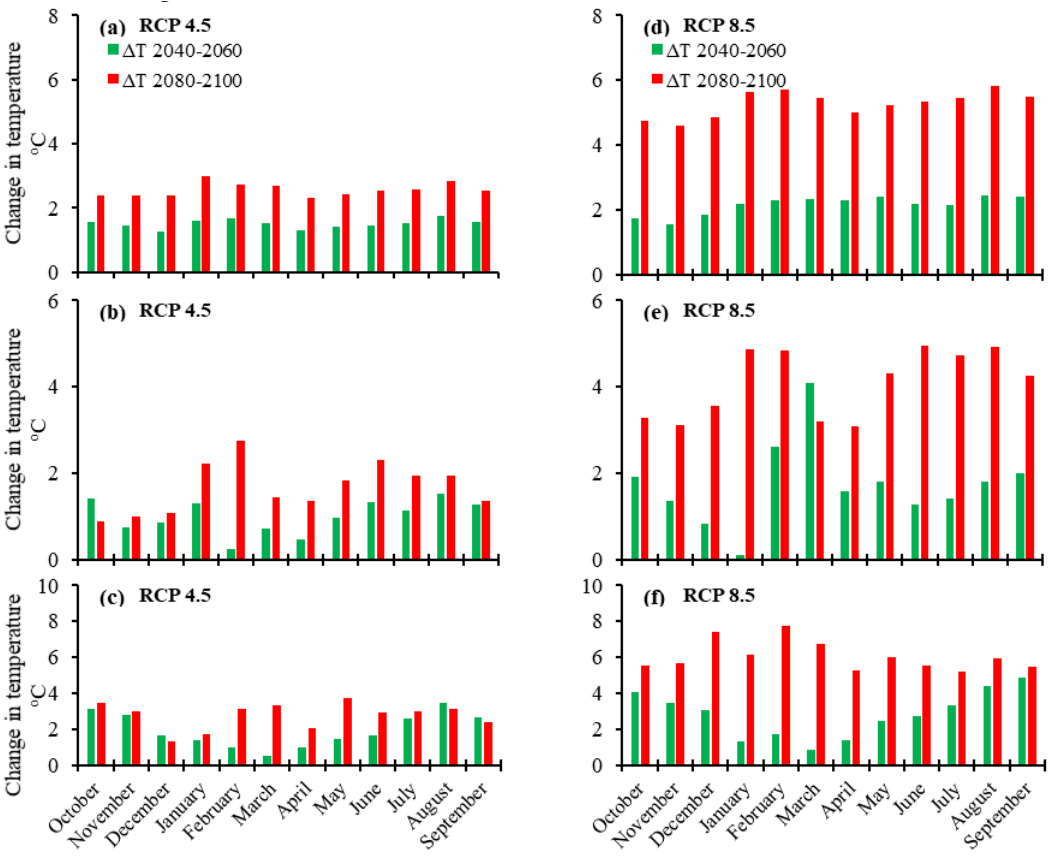
Figure 4. Projected monthly temperature changes during 2040–2060 and 2080–2100: ( a ) average, ( b ) lower, and ( c ) higher under RCP 4.5; and ( d ) average, ( e ) lower, and ( f ) higher under RCP 8.5.